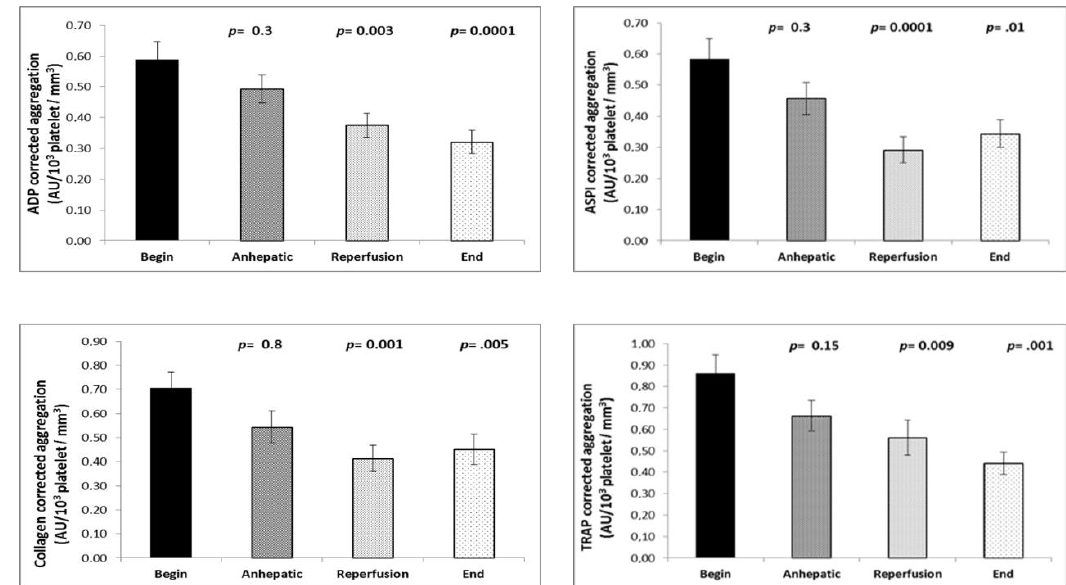
Figure 6. Time course of the platelet aggregation ratio (correction for platelet count) induced by adenosine diphosphate (ADP), arachidonic acid (ASPI), collagen, and thrombin receptor-activating peptide (TRAP) in liver transplantation patients ( n = 35). Platelet function decreases with the reperfusion of the transplant. Values are given as mean and SEM. The Mann – Whitney U-test was used to determine changes in platelet aggregation from the initial value during the course of surgery.